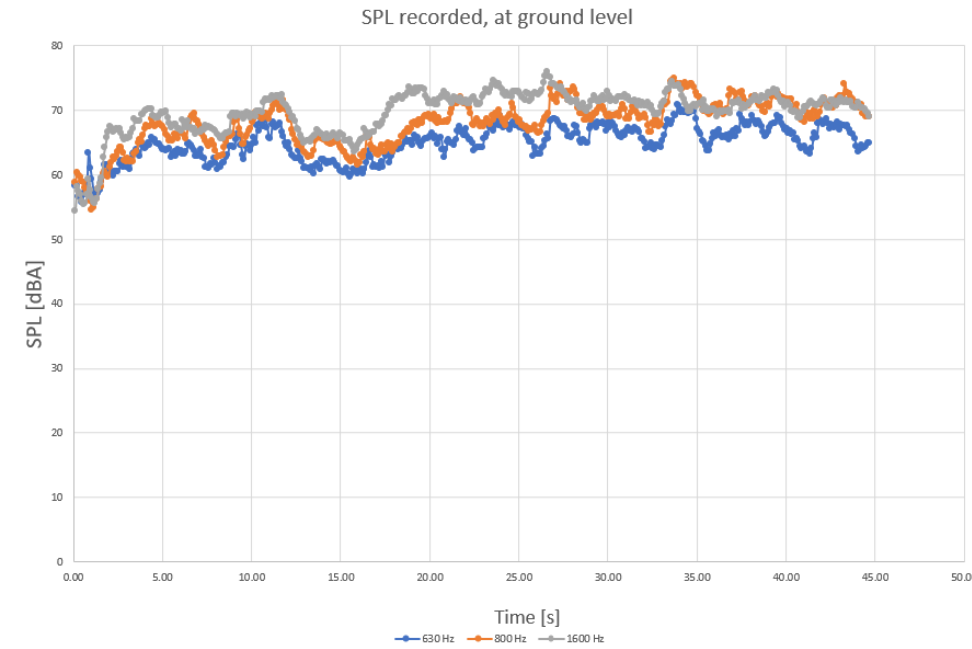
Figure 5. Recorded SPL at medium frequencies (630 Hz, 800 Hz, and 1.6 kHz traffic noise, in blue— 630 Hz, orange—800 Hz, grey—1.6 kHz), ground level. blue—630 Hz, orange—800 Hz, grey—1.6 kHz), ground level.